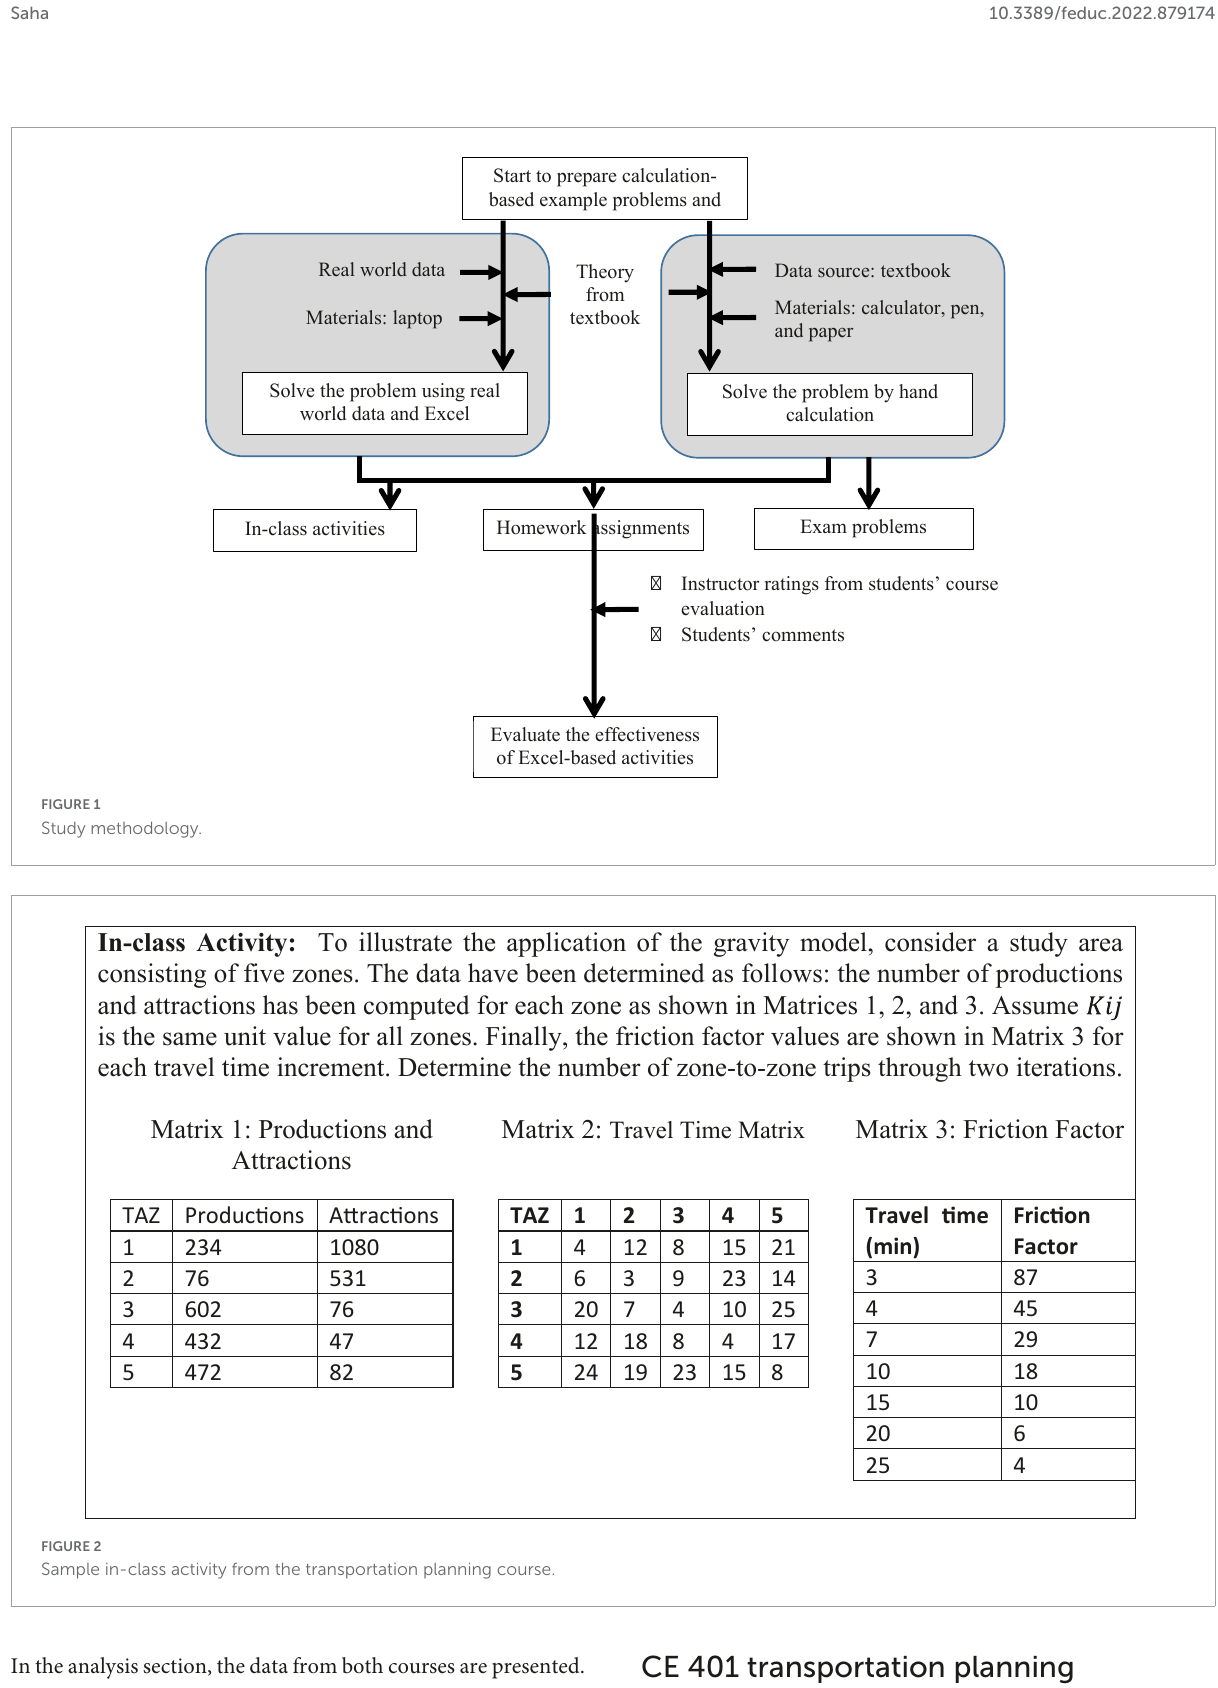
In the analysis section, the data from both courses are presented. The courses will be referred to as Transportation Planning and Transportation Engineering for discussion purposes. Both are junior/senior-level courses,